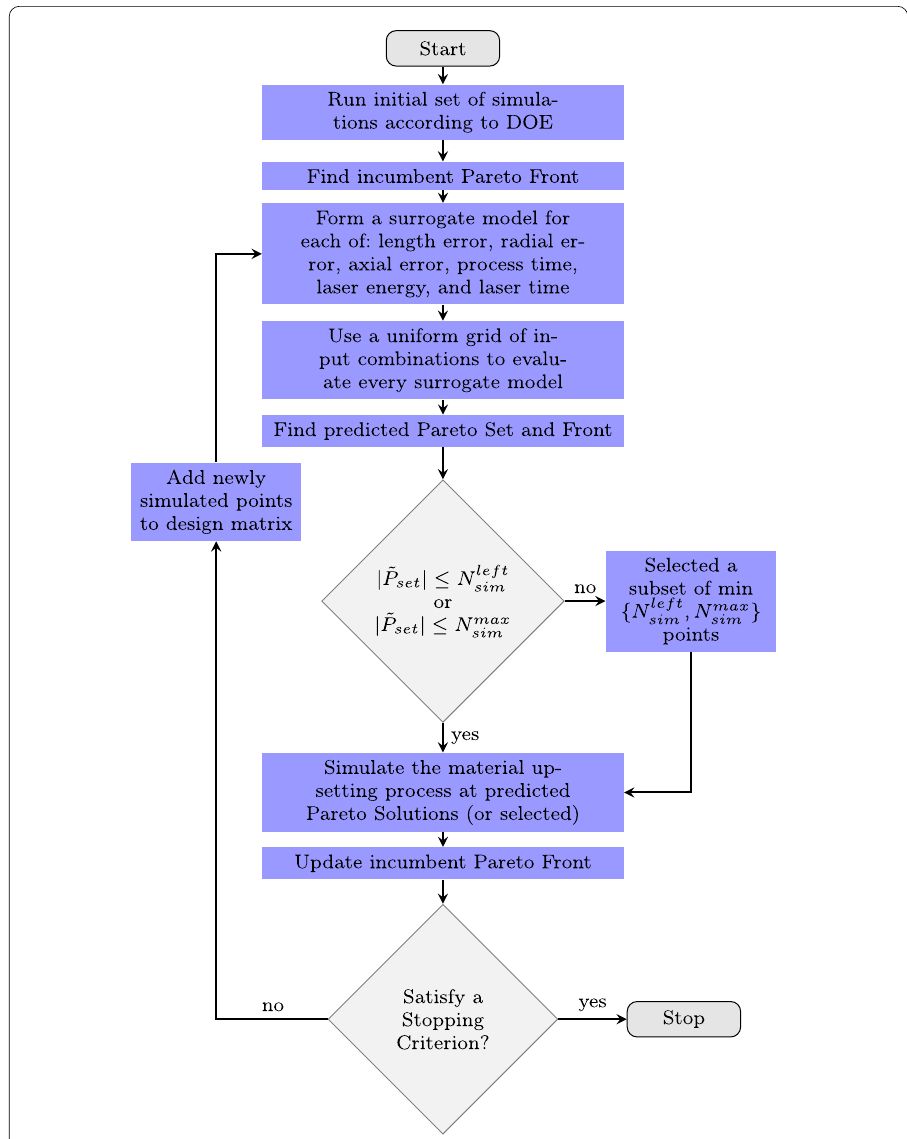
Figure 7 Multiobjective optimization method flow diagram for the laser-based material accumulation process